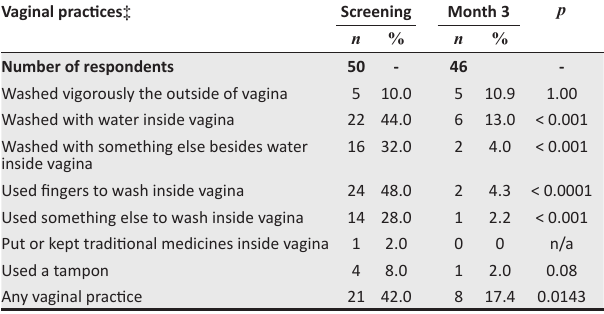
TABLE 2: Vaginal practices at screening † and at month 3. Vaginal practices